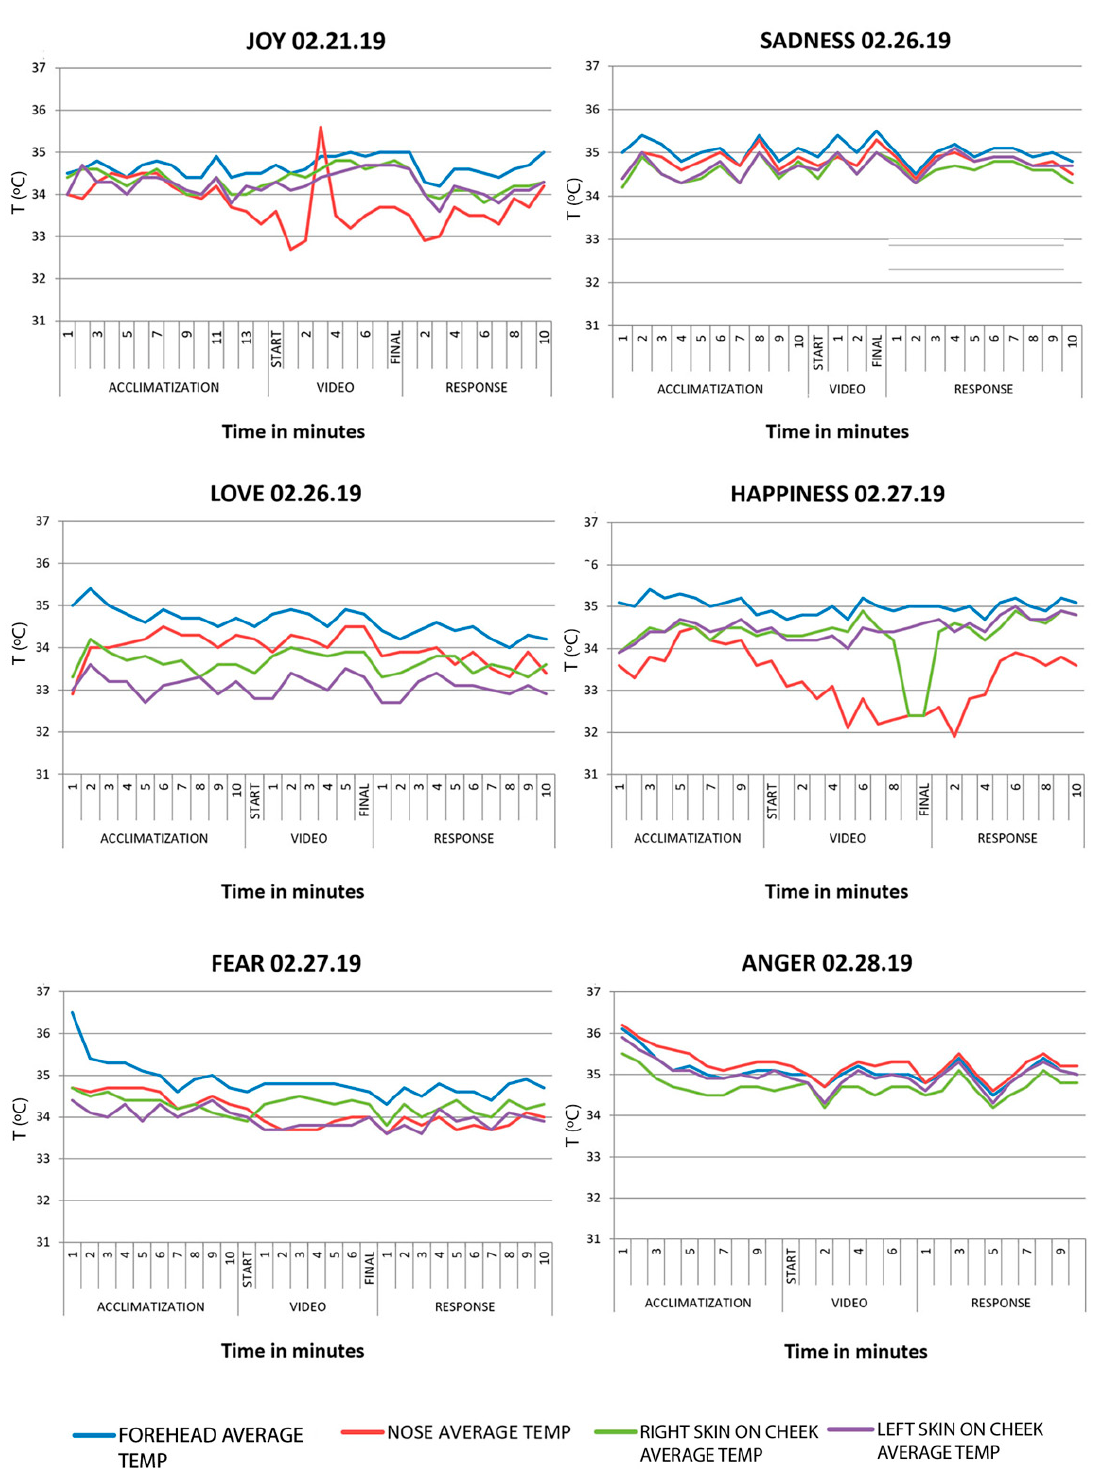
Figure 5. Lineal graphs showing the variation of the average temperature by facial areas during part A of the study.